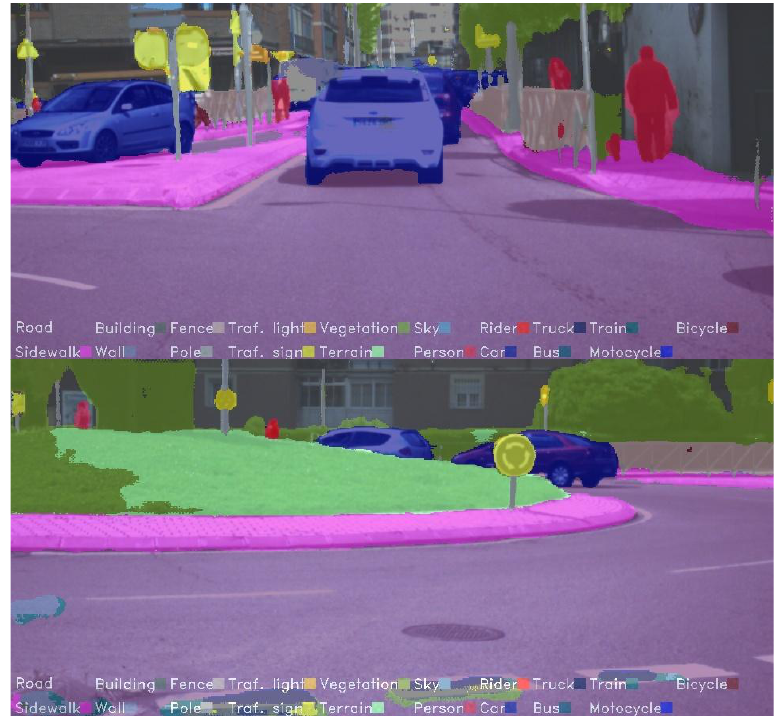
Figure 6. Semantic segmentation of a driving